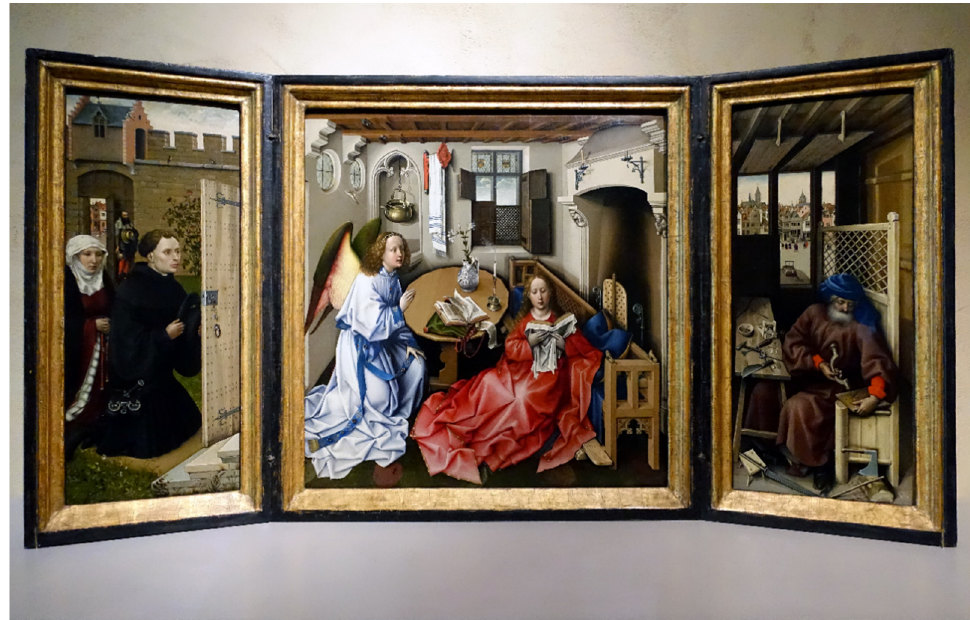
Figure 1. Master of Flémalle (Robert Campin?) and workshop, Merode Altarpiece , ca. 1425–1428. Oil on wood, 64.1 × 117.8 cm. New York, Metropolitan Museum of Art. © Steven Zucker, Smarthistory, https://www.flickr.com/photos/profzucker/24521557023 (accessed on 29 October 2021). Image in the public domain.